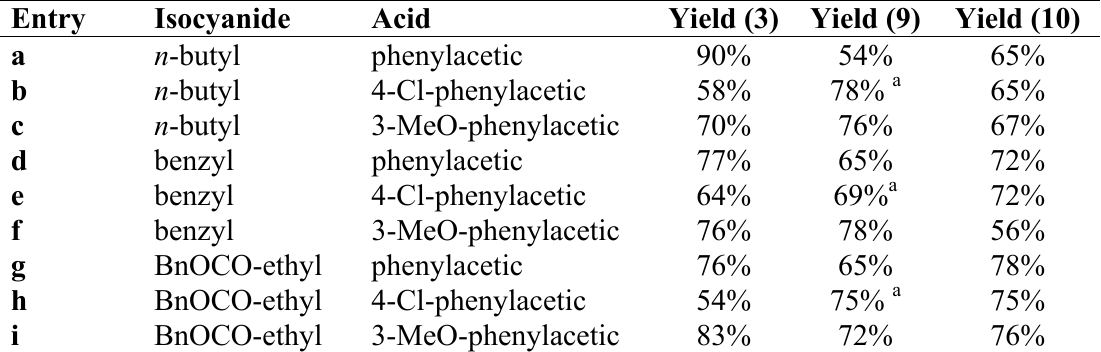
Table 1. Results obtained for the synthesis of the 27 member library employing three different arylacetic acids and three different